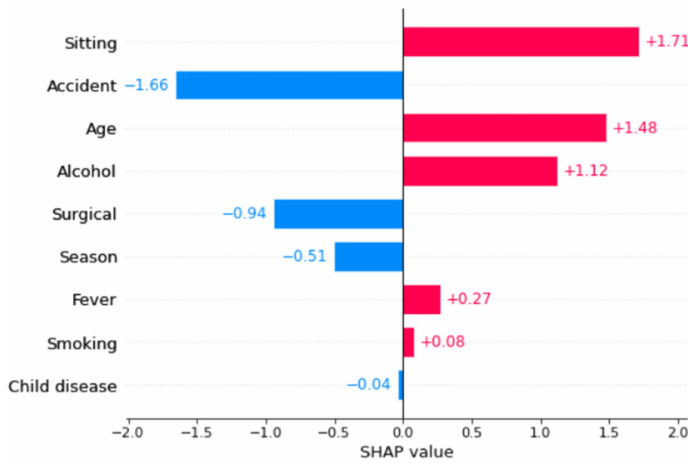
Figure 5. Local visual explanation of the proposed system using SHAP.